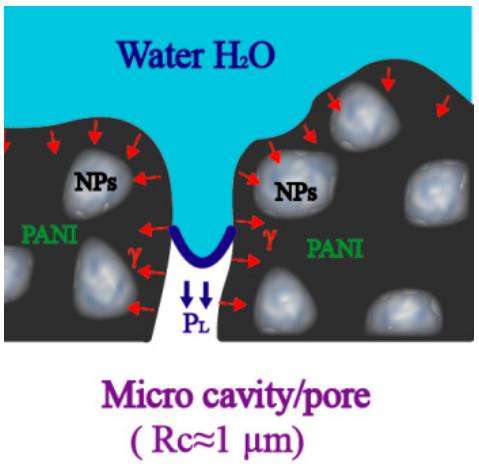
Figure 7. Schematic illustration of the penetration of water on the cavity/pore of PANI/NPs described by the Laplace pressure.